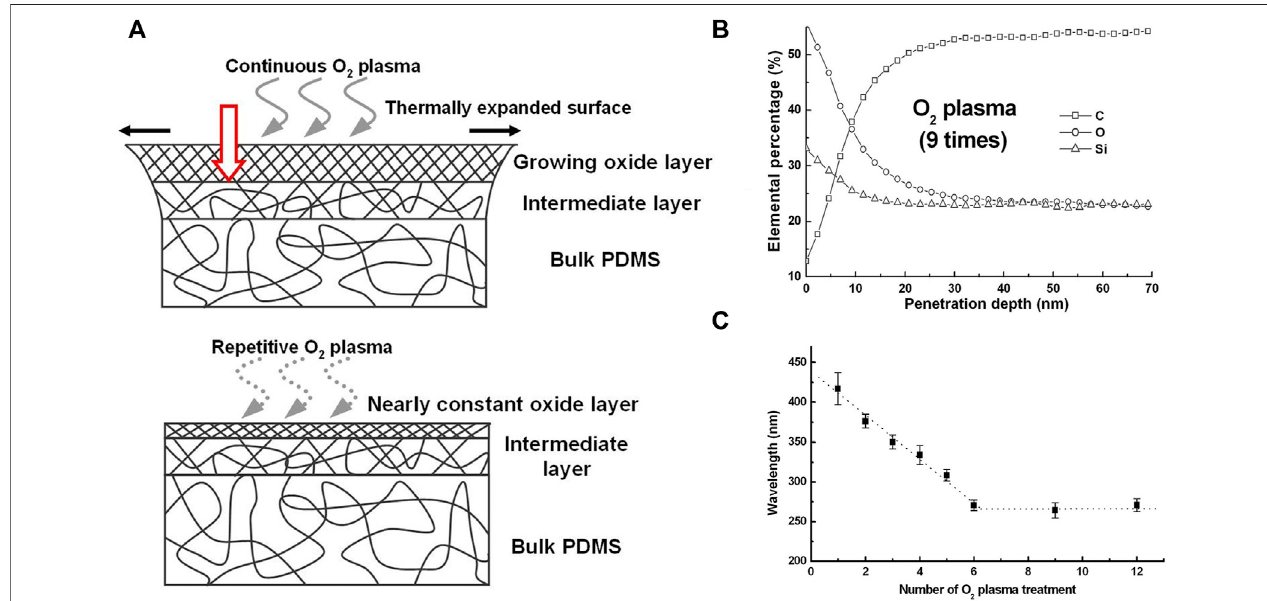
FIGURE 4 | Wrinkle suppression through fi lm thickness control. (A) Schematics of the comparison between the development of the surface oxide layer by continuous and intermittent O 2 plasma treatment. (B) Elemental distribution of C, O, and Si with depth, indicating the formation of a SiO 2 -based rigid oxide layer. (C) WavelengthofthegeneratedwrinkleswiththenumberofintermittentO 2 plasmatreatments.Thewavelengthbecomesstableaftersixcyclesoftreatment,indicatingthat the thickness of the rigid layer no longer increases (reproduced with permission from Park et al., 2010, The Royal Society of